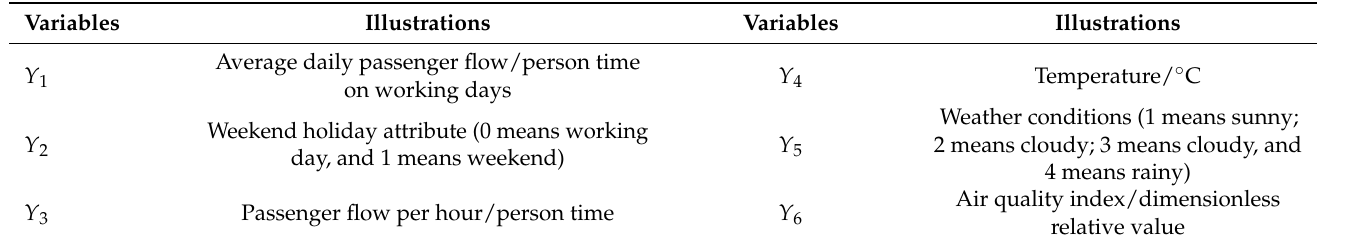
Table 3. Influencing parameters of passenger flow analysis and